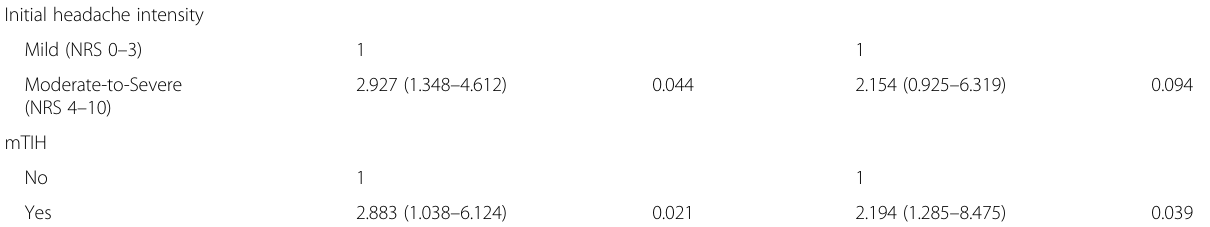
Table 2 Risk factors for moderate-to-severe headache at the 12-month follow-up (Continued) Initial headache